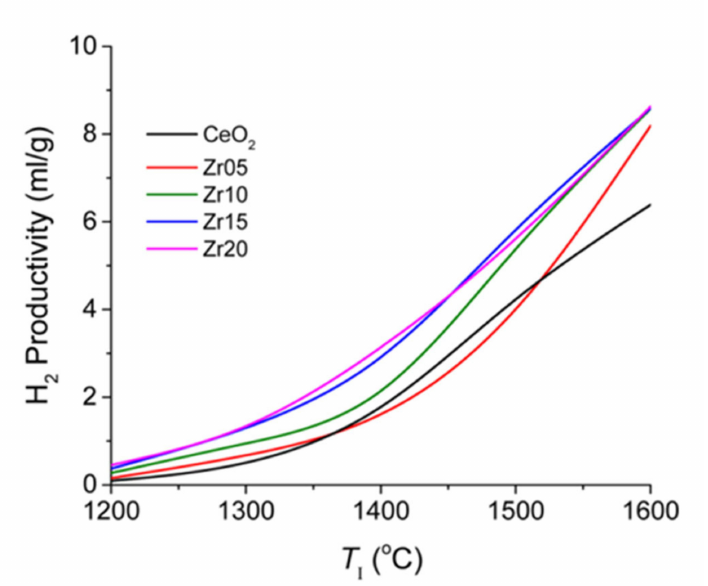
Figure 11. Hydrogen yields for isothermal two-step thermochemical water splitting at different doping concentrations of zirconium in cerium oxide, including cerium (IV) oxide without doping. Reprinted from